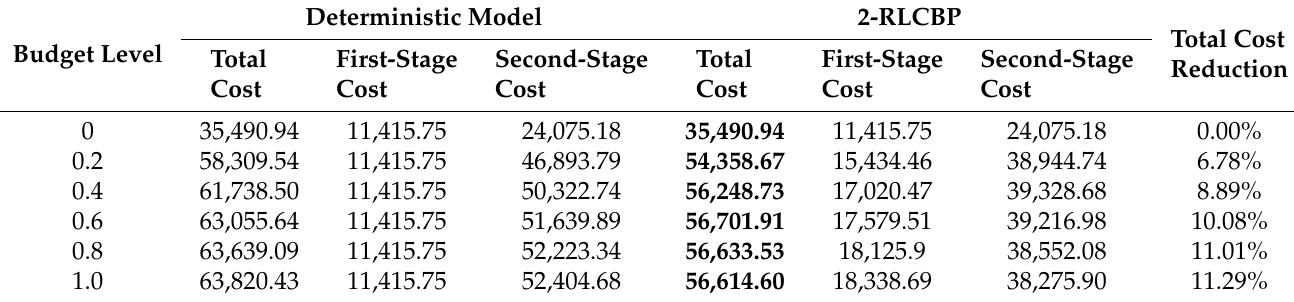
Table 6. Results of different budget levels.